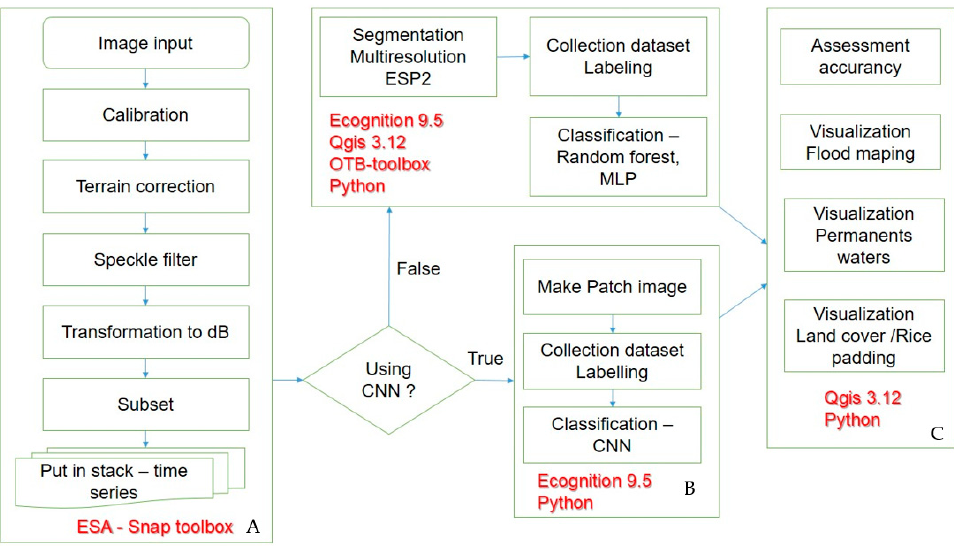
Figure 3. Process flowchart for flood zones, permanent waters and land cover mapping: pre-processing ( A ), image processing ( B ) and post-classification ( C ).